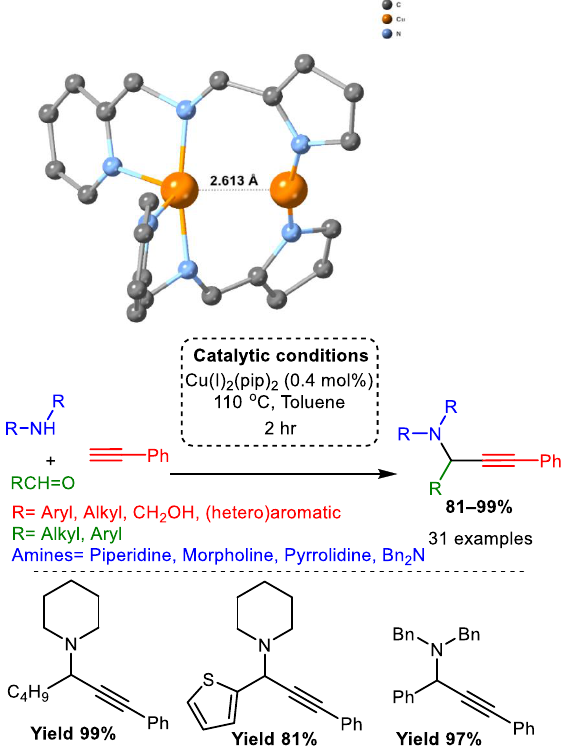
Scheme 57. ( left ) The crystallographically characterised pre-catalyst ( right ) the scope and limita- tions of the method catalysed by the dimeric